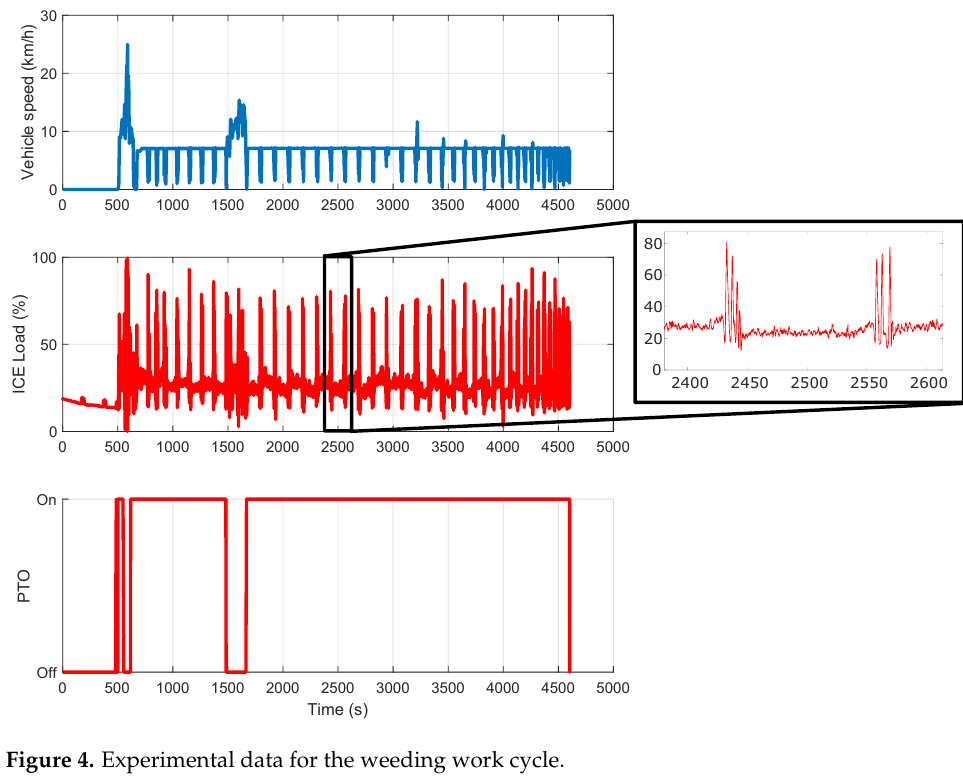
Figure 4. Experimental data for the weeding work cycle.